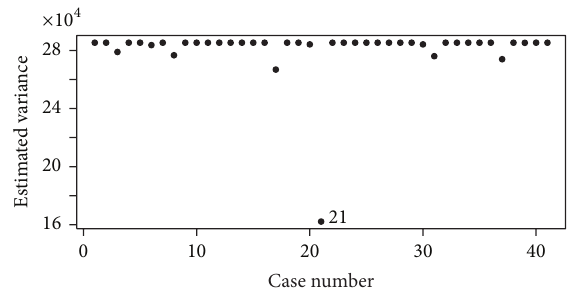
Figure 3: Plot of error variance estimates ( ̂𝜎 2 𝑖 ) versus case number.